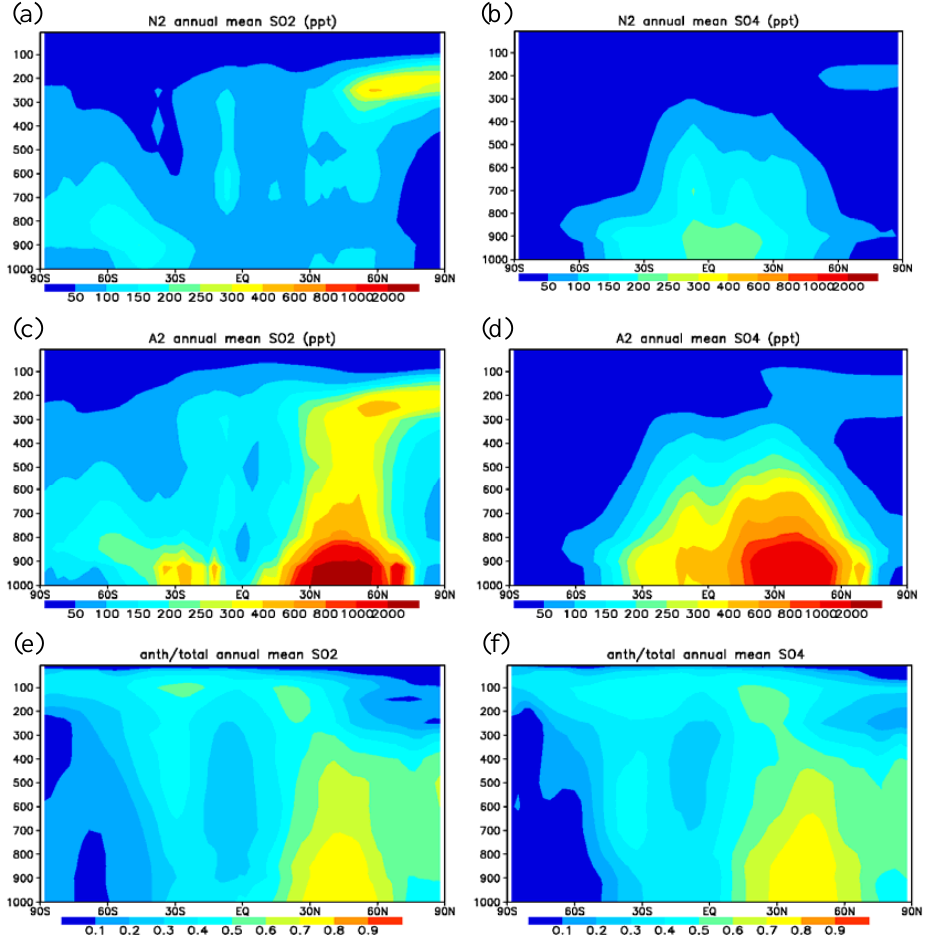
Fig. 4. Comparison of the vertical profiles of zonal-mean SO 2 (left) and sulfate (right) concentrations. Top: concentration (in parts per trillion by volume; ppt) under natural conditions (N2); Middle: concentration (in ppt) under polluted conditions (A2); Bottom: ratio of anthropogenic to total (A2–N2:A2)